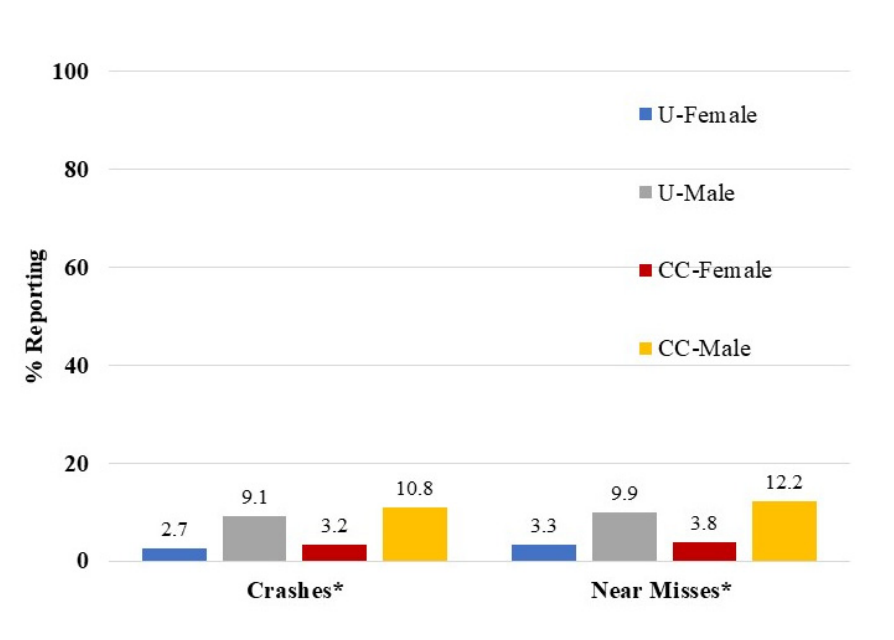
Figure 3. Proportion of participants reporting “near-miss” incidents and crashes while operating farm equipment on roadways. Note: U-Female = University female; U-Male = University male; CC-Female = Community College Female; CC-Male = Community College Male. * Indicates differences between male and female responses, using a 2 proportions Z-test ( p ≤ 0.05)